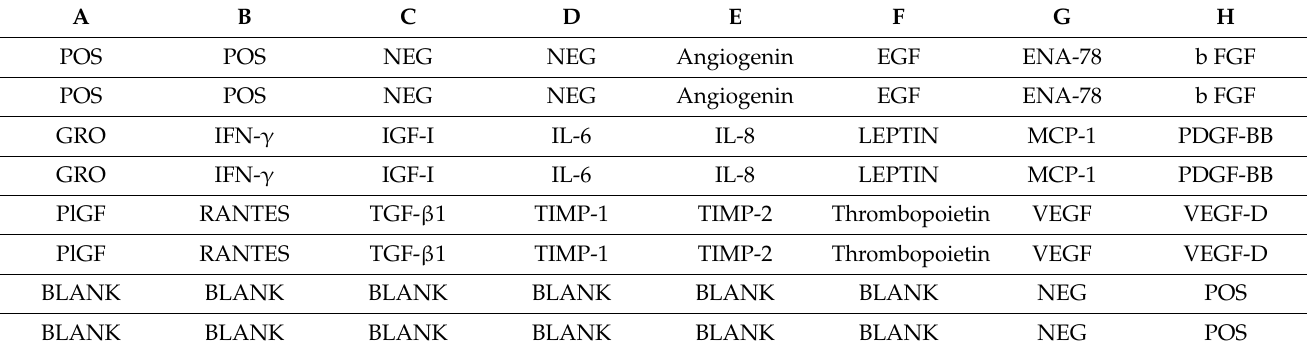
Table 2. The order of the markers on the Human Angiogenesis Antibody